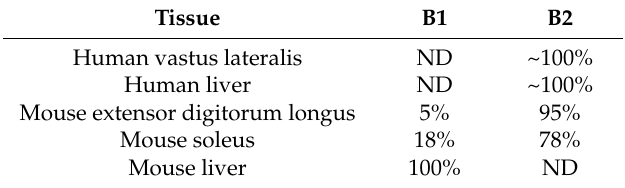
Table 1. The AMPK β subunit isoform distribution in human and mouse tissues.